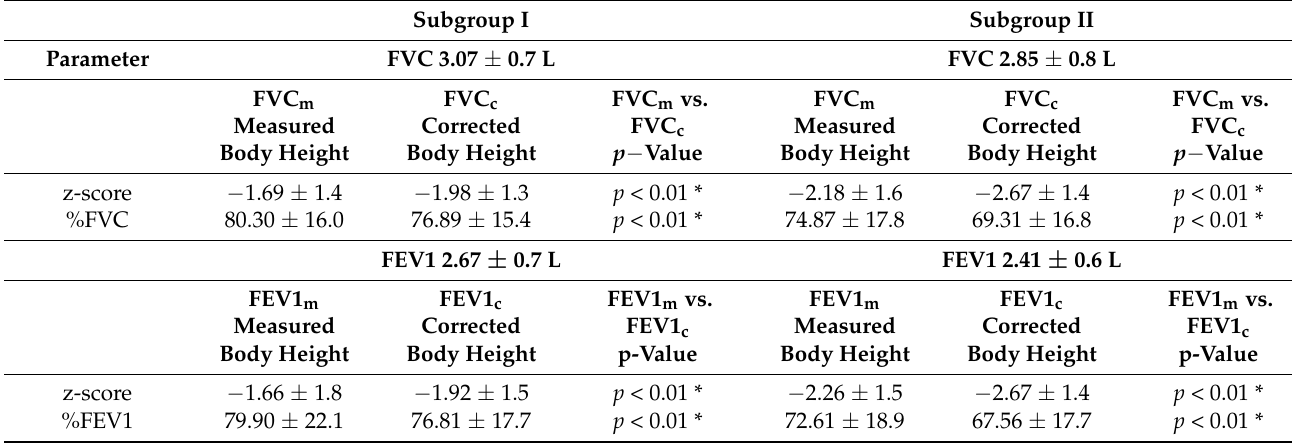
Table A4. Comparison of the pulmonary parameters calculated for the measured versus the corrected body height in subgroup I, N = 84 and subgroup II, N =